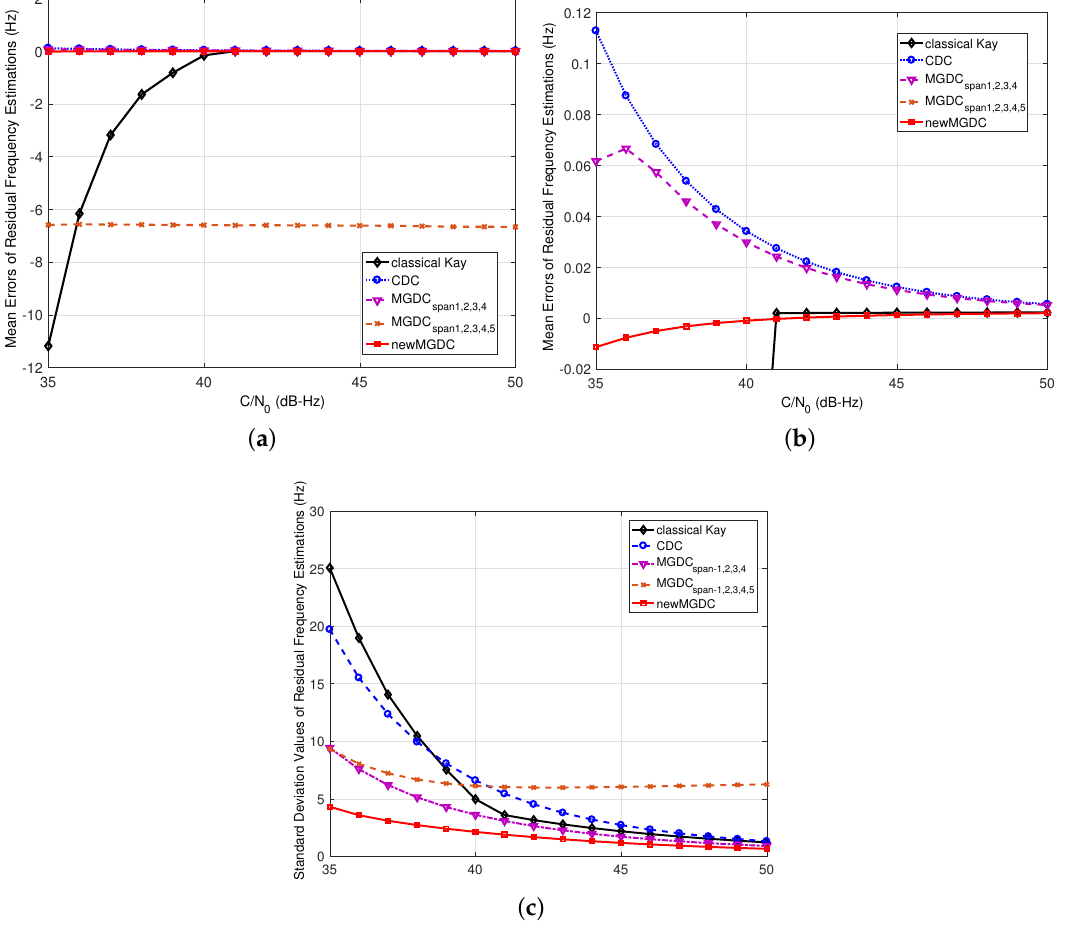
= 100 Hz, T = 1 ms, coh d